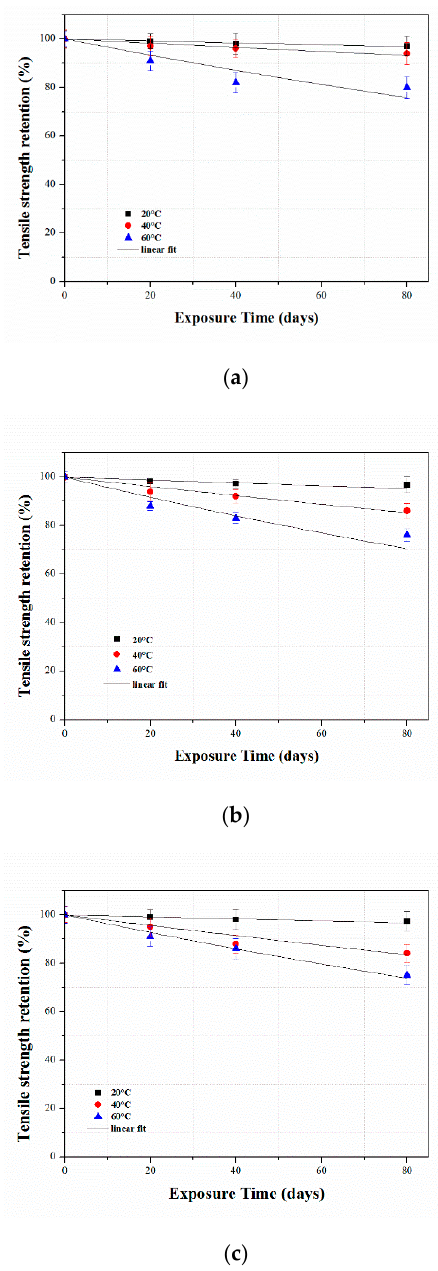
Figure 8. Predictions of CFRP composite at given temperatures (20 °C, 40 °C and 60 °C) in different immersion solutions ( a ) Water, ( b ) HCl and ( c ) NaOH solution.